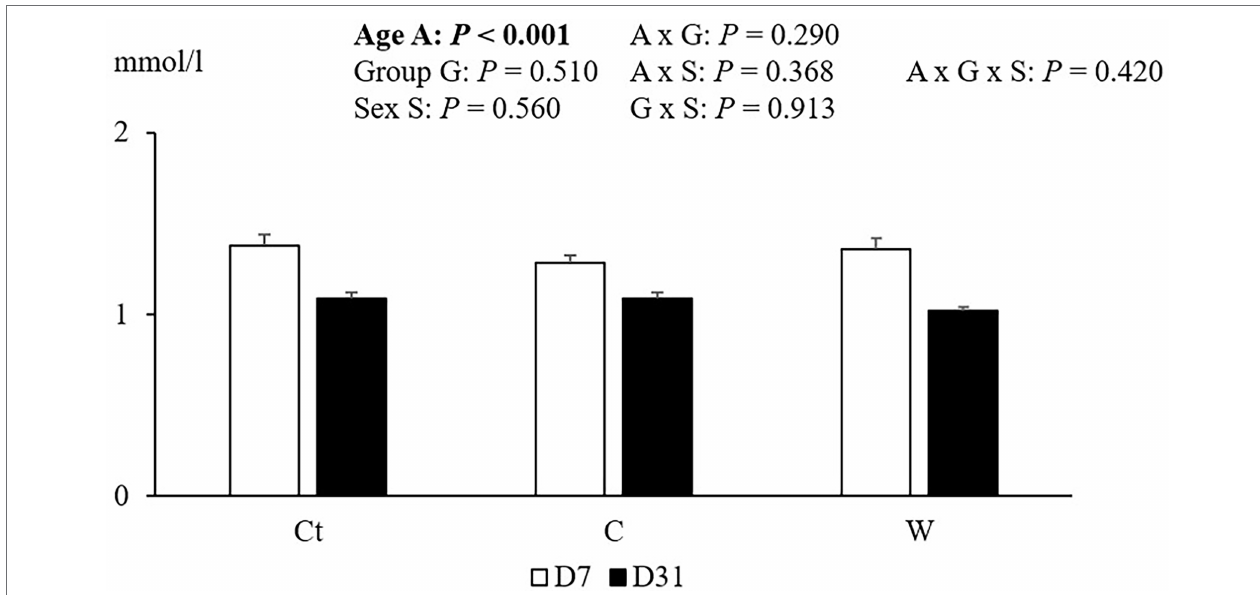
FIGURE 5 | Total antioxidant power (TAS) of plasma for E chickens (from eggs of breeder flock at the end of the laying period) at 7 and 31 days, depending on egg storage conditions and age of broilers ( n = 8 animals, by sex per group). Ct: control group; C: cool storage; and W: warm